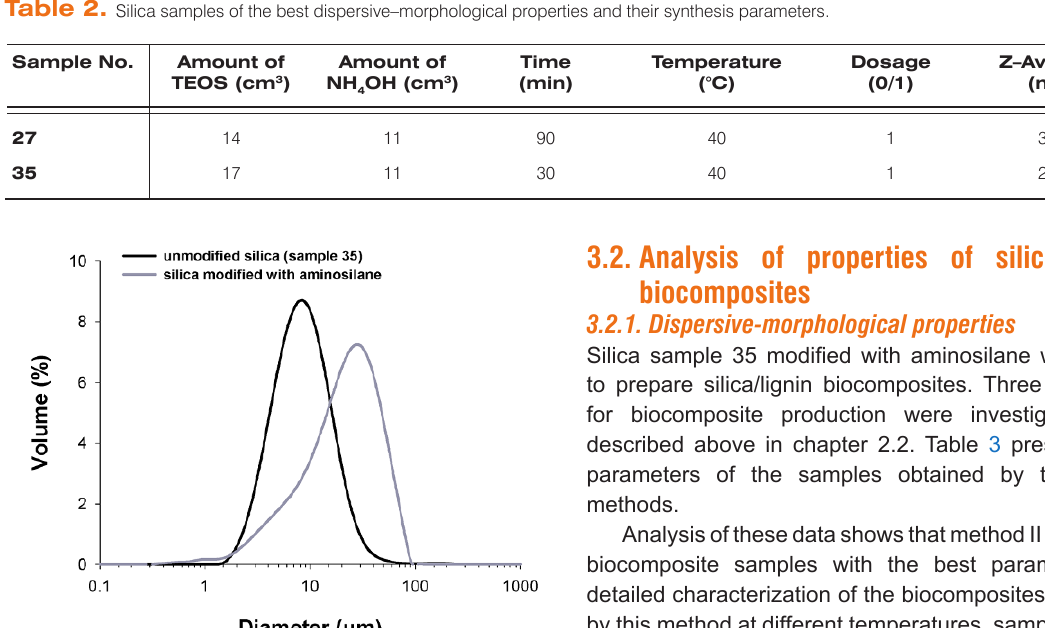
Figure 2. Particle size distributions of unmodified and aminosilane- grafted silicas (Mastersizer